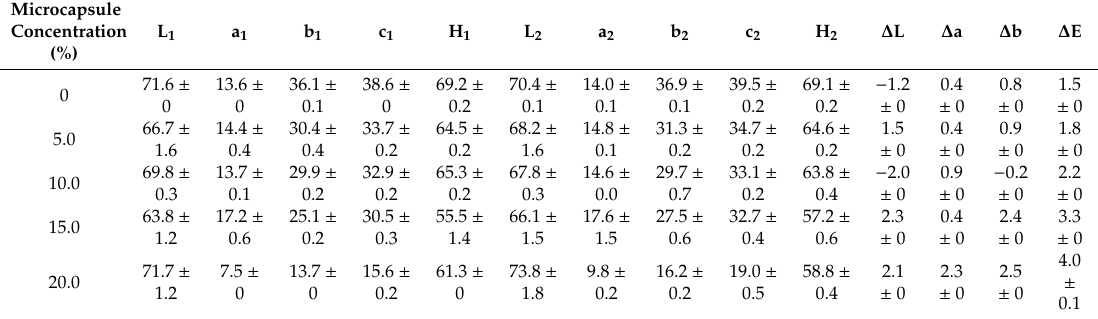
Table 3. E ff ect of microcapsule concentration with 0.42:1 core-wall ratio on the color di ff erence.